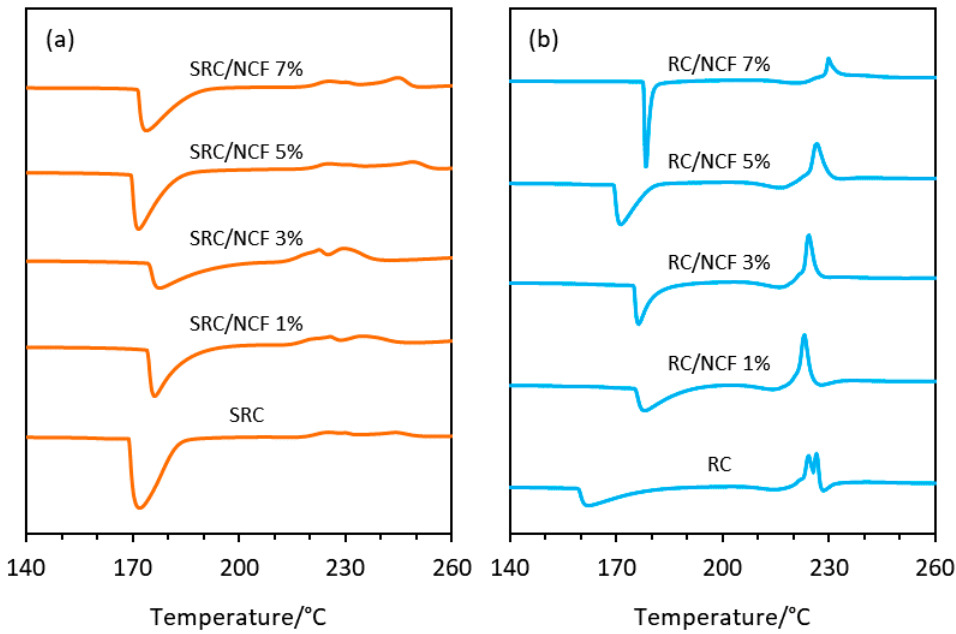
Figure 6. Di ff erential scanning calorimetry (DSC) thermograms of the ( a ) SRC / NCF and ( b ) RC / NCF Figure 6. Differential scanning calorimetry (DSC) thermograms of the ( a ) SRC/NCF and ( b ) RC/NCF film formulations. Samples were heated under nitrogen (flow rate 20 mL min − 1 ) from 50 to 320 ◦ C at a film formulations. Samples were heated under nitrogen (flow rate 20 mL min -1 ) from 50 to 320 °C at a heating rate of 10 ◦ C min − 1 heating rate of 10 °C min -1 .